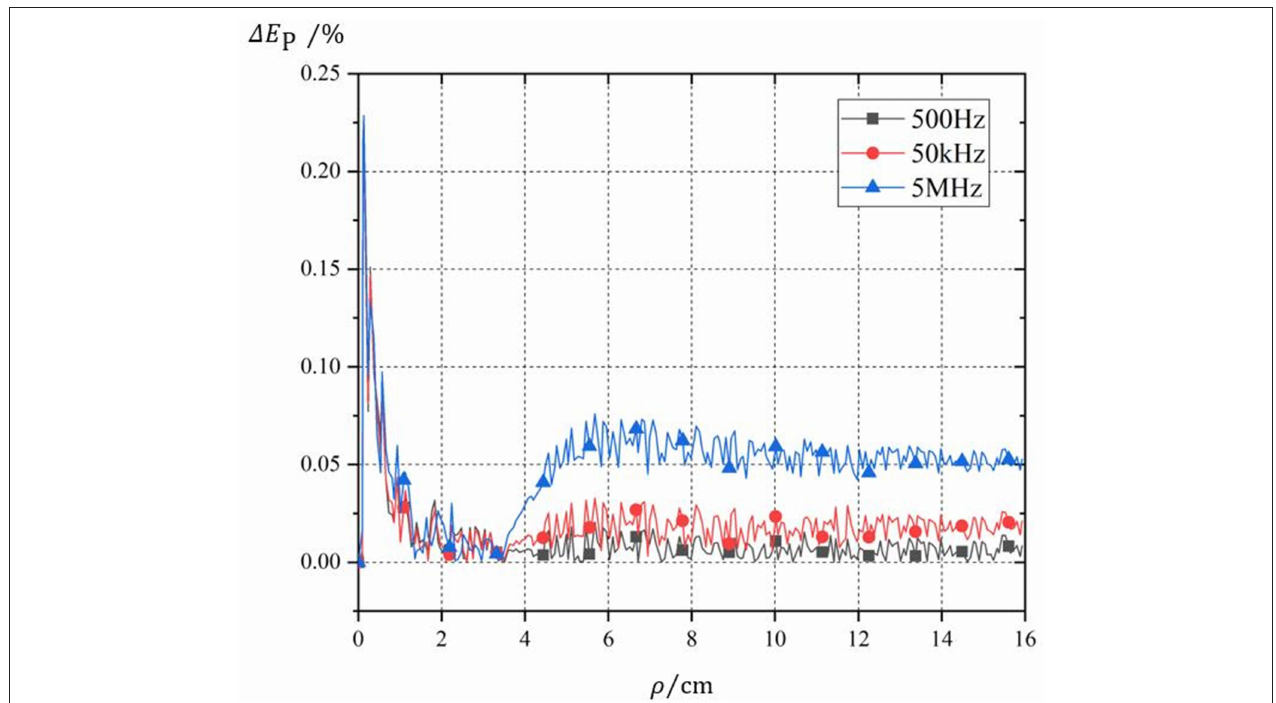
FIGURE 3 | Schematic diagram of the relative error between simulation and calculation results.